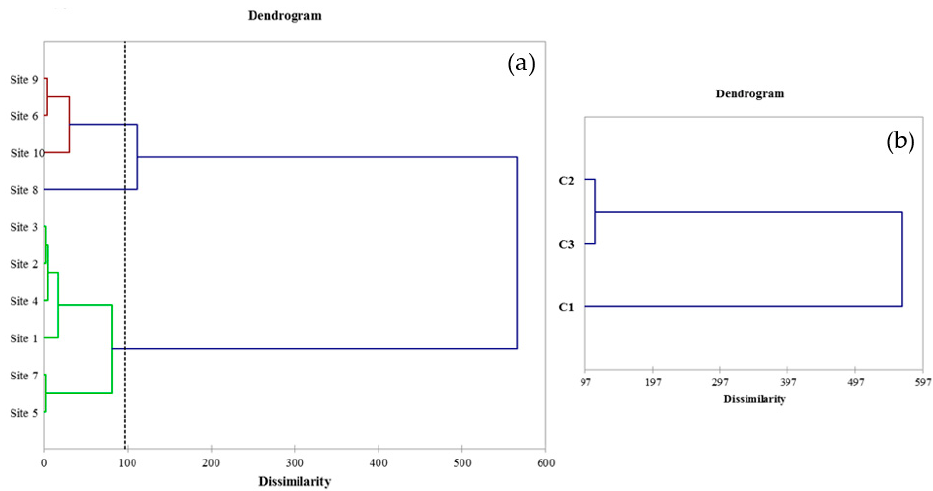
Figure 3. Results, before ( a ) and after ( b ) the automatic cut.